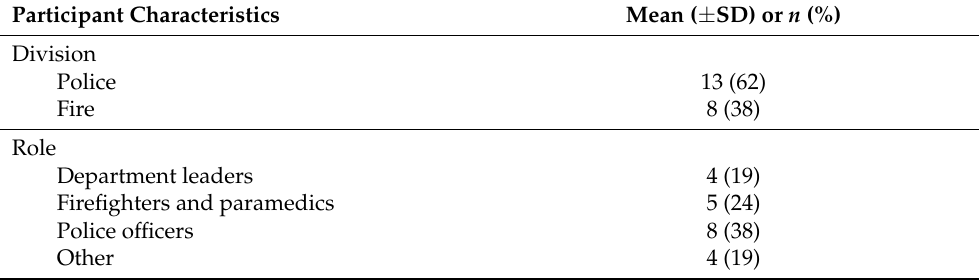
Table 1. Cont . Participant